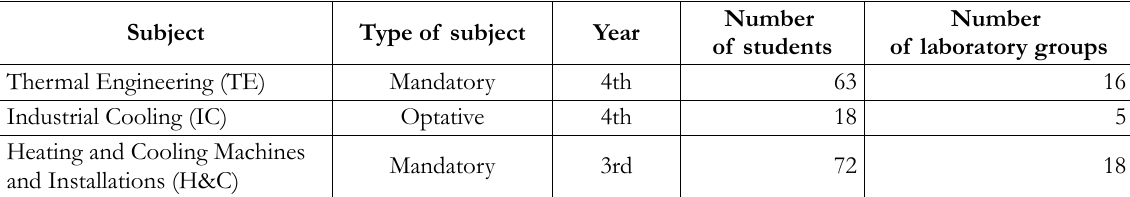
Table 3. Student enrollment